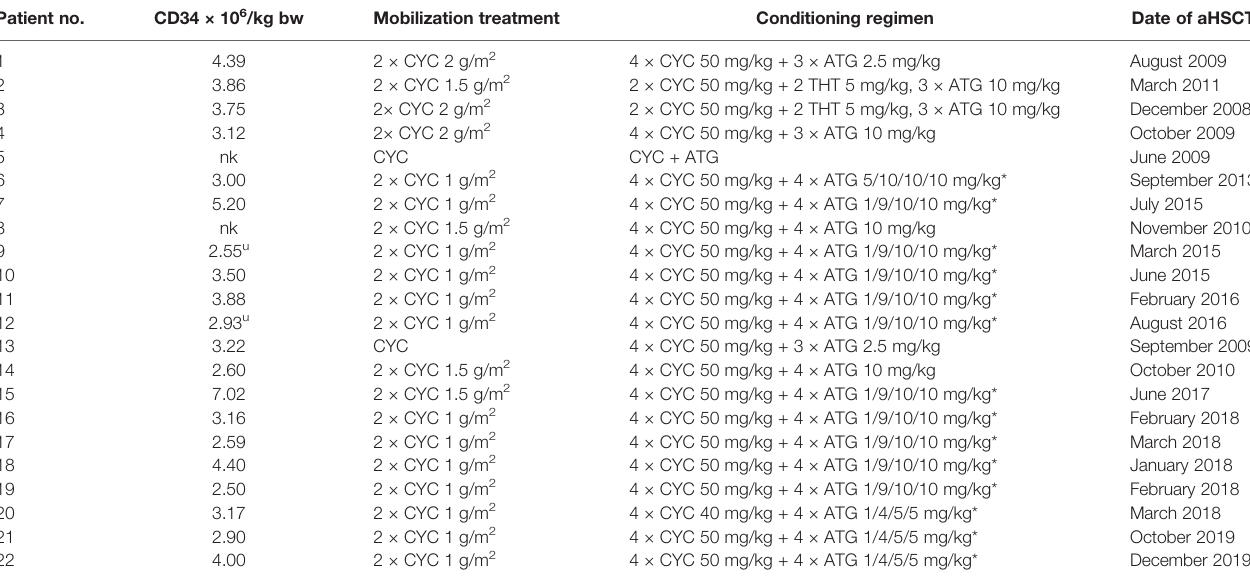
TABLE 2 | Individual transplantation data. Patient no. CD34 × 10 6 /kg bw Mobilization